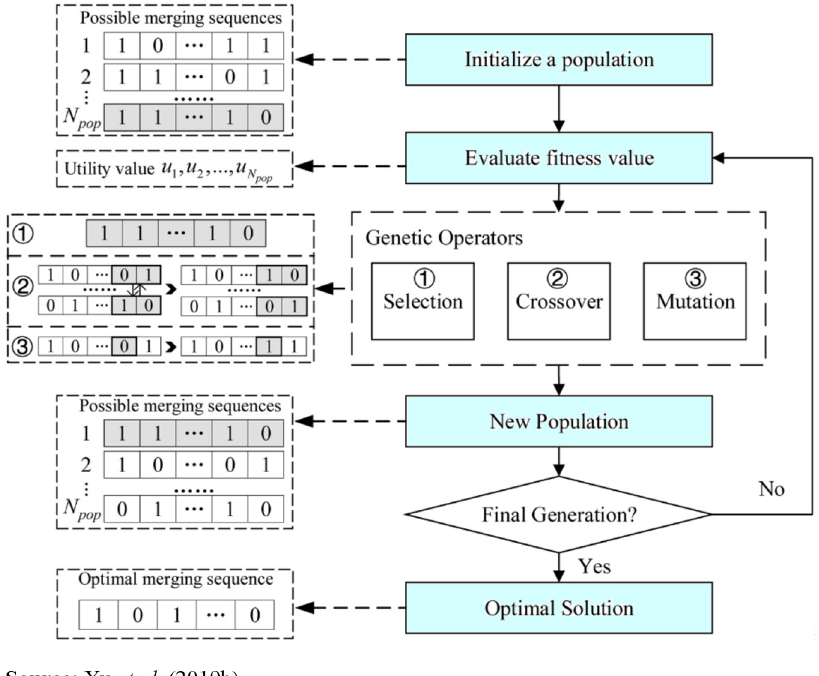
Figure 2 Merging sequence representation and fl owchart of used genetic